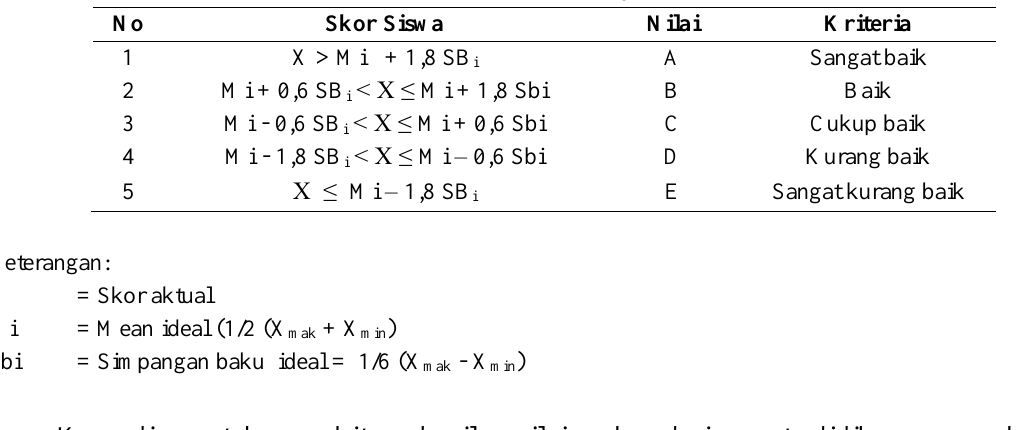
Tabel 1. Konversi Skor Menjadi Skala